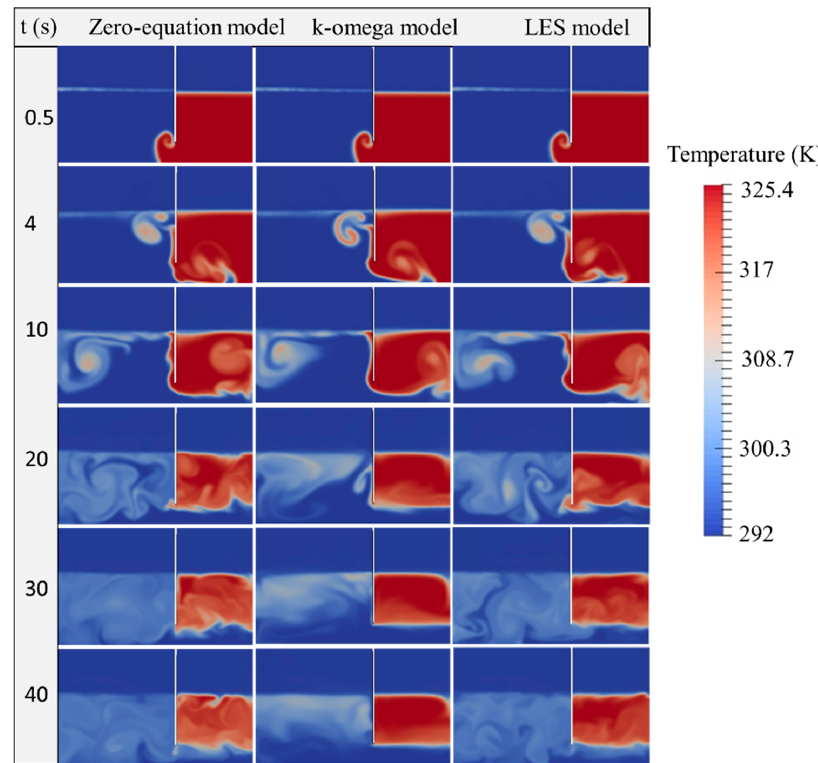
Figure 8. Temperature fields at different instants for the three turbulence models.